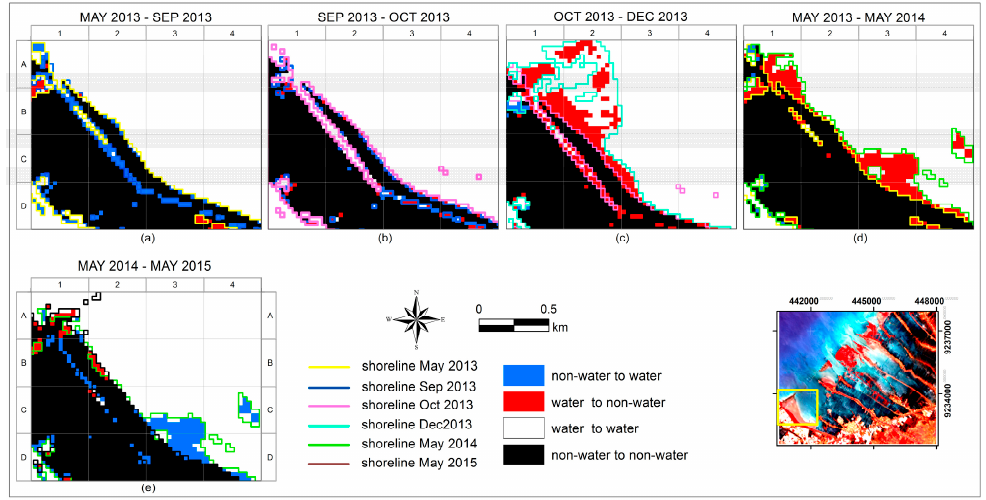
Figure 10 . Post classification comparison of shoreline as the results of hardened classification: ( a – c ) the changes of shoreline in three consecutive dates in 2013; ( d ) shoreline changes from 2013 to 2014; and ( e ) from 2014 to 2015.